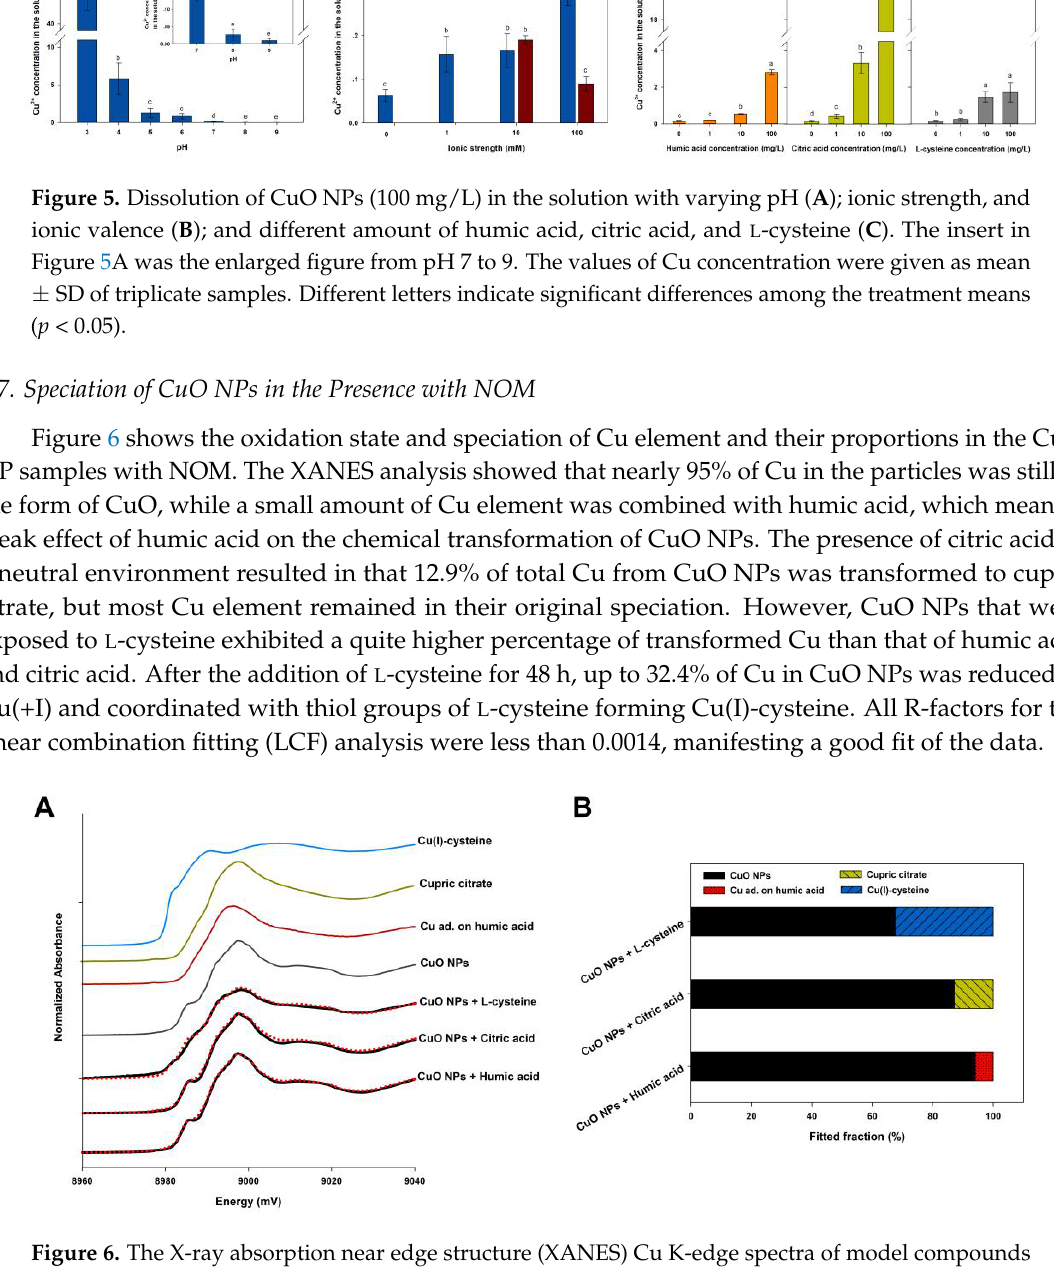
Figure 6. The X-ray absorption near edge structure (XANES) Cu K-edge spectra of model compounds and CuO NPs in the solution with NOM ( A ); the red dashed lines are the linear fitting results. Cu ad. on humic acid: Cu adsorbed on the humic acid. Results of fitting the Cu K-edge XANES spectra of CuO NP samples exposed to NOM using a linear combination of the data for the model compounds ( B ).